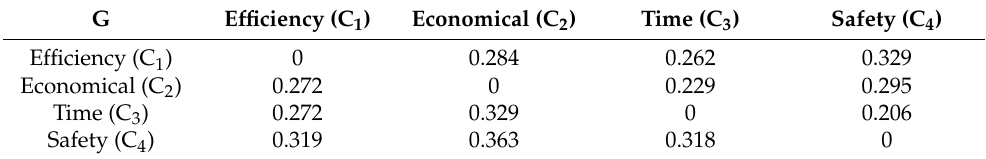
Table 10. Normalized direct influence matrix G between BPM tool selection main criteria.